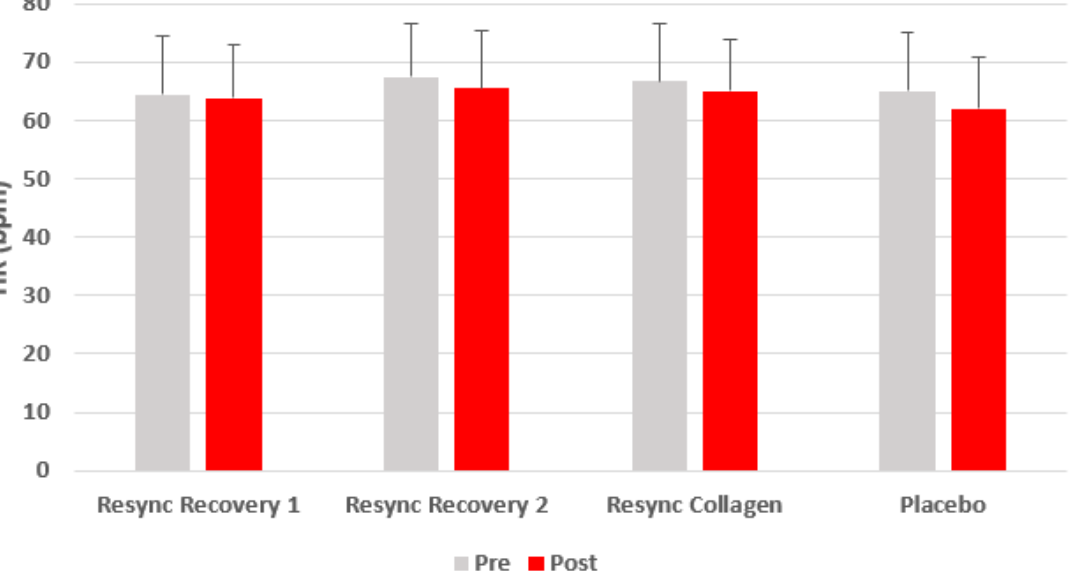
Figure 1. Heart rate before and 75 min after ingestion of Resync or placebo. Values are the mean ± SD. No differences of statistical significance were noted ( p > 0.05). Note: Resync Recovery 1 = 1 serving; Resync Recovery 2 = 2 servings.